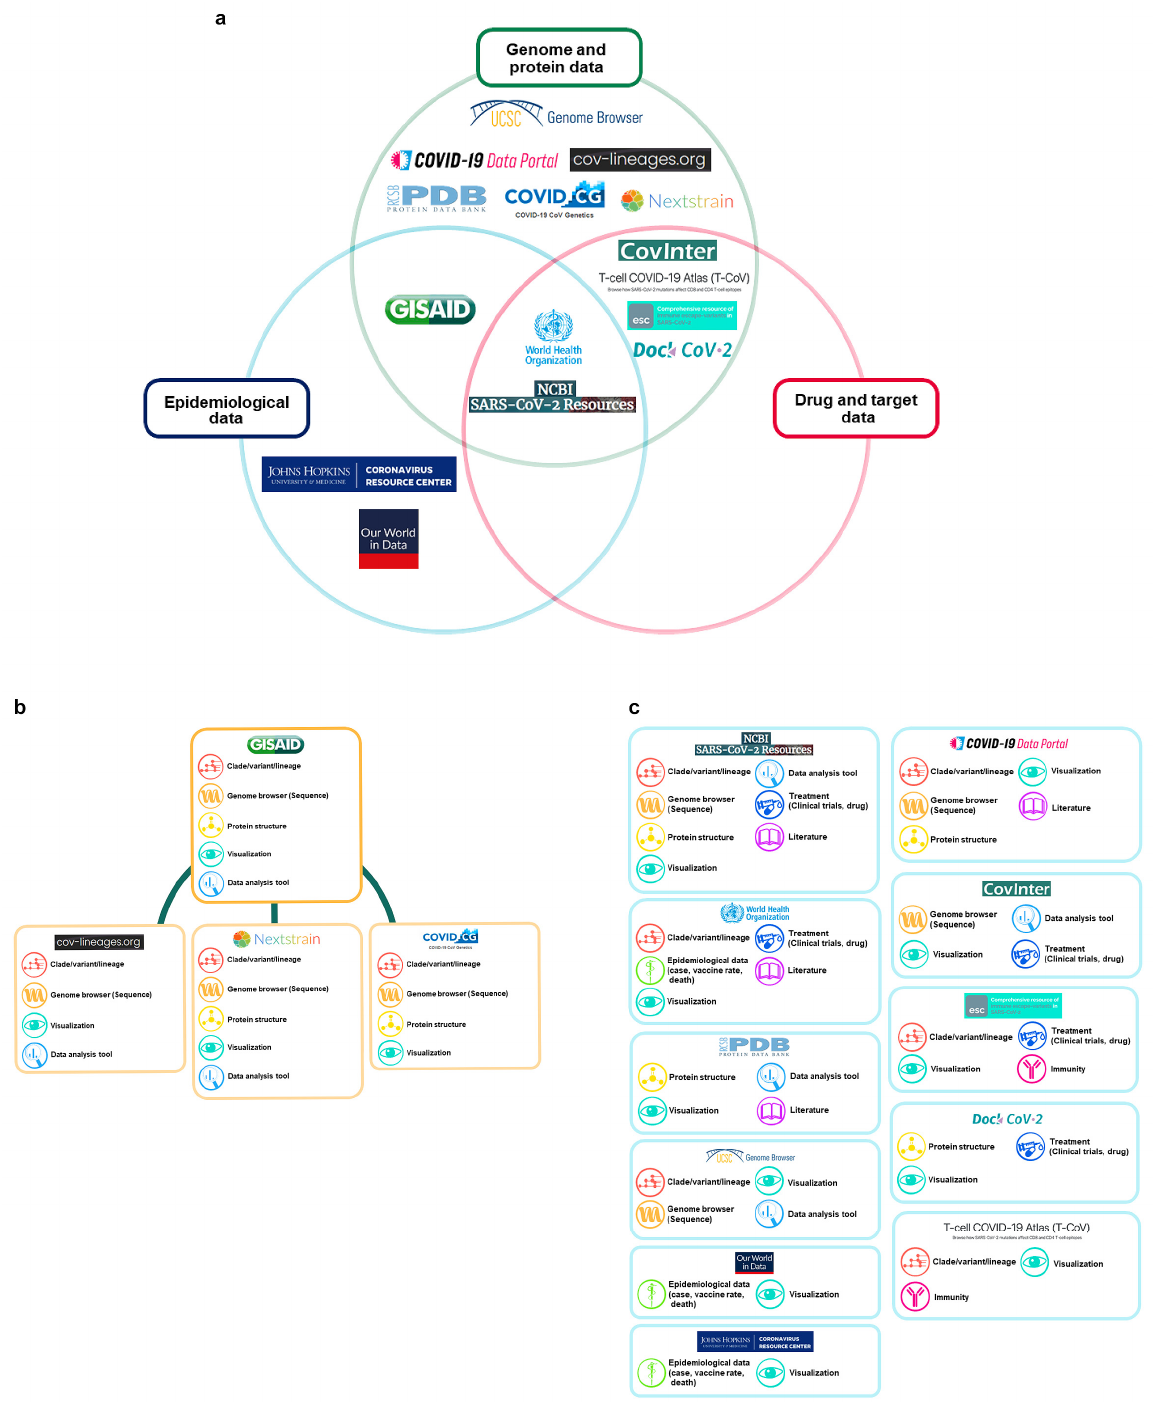
Figure 1. COVID-19 database categorization and main functions. ( a ) Upon investigating 15 databases, these were categorized into three categories: genome and protein data, epidemiological data, and drug and target data. ( b ) There are four databases based on GISAID data. The main functions of the databases are clade/variant/lineage, genome browser (sequence), protein structure, visualization, and data analysis. ( c ) There are 11 databases that have collected their data independently. The main functions are clade/variant/lineage information, genome browser (sequence), protein structure, epidemiological data (cases, vaccine rates, deaths), visualization, data analysis tool, treatment (clinical trials, drugs), literature, and immunity. These main functions vary depending on the purpose of the database.